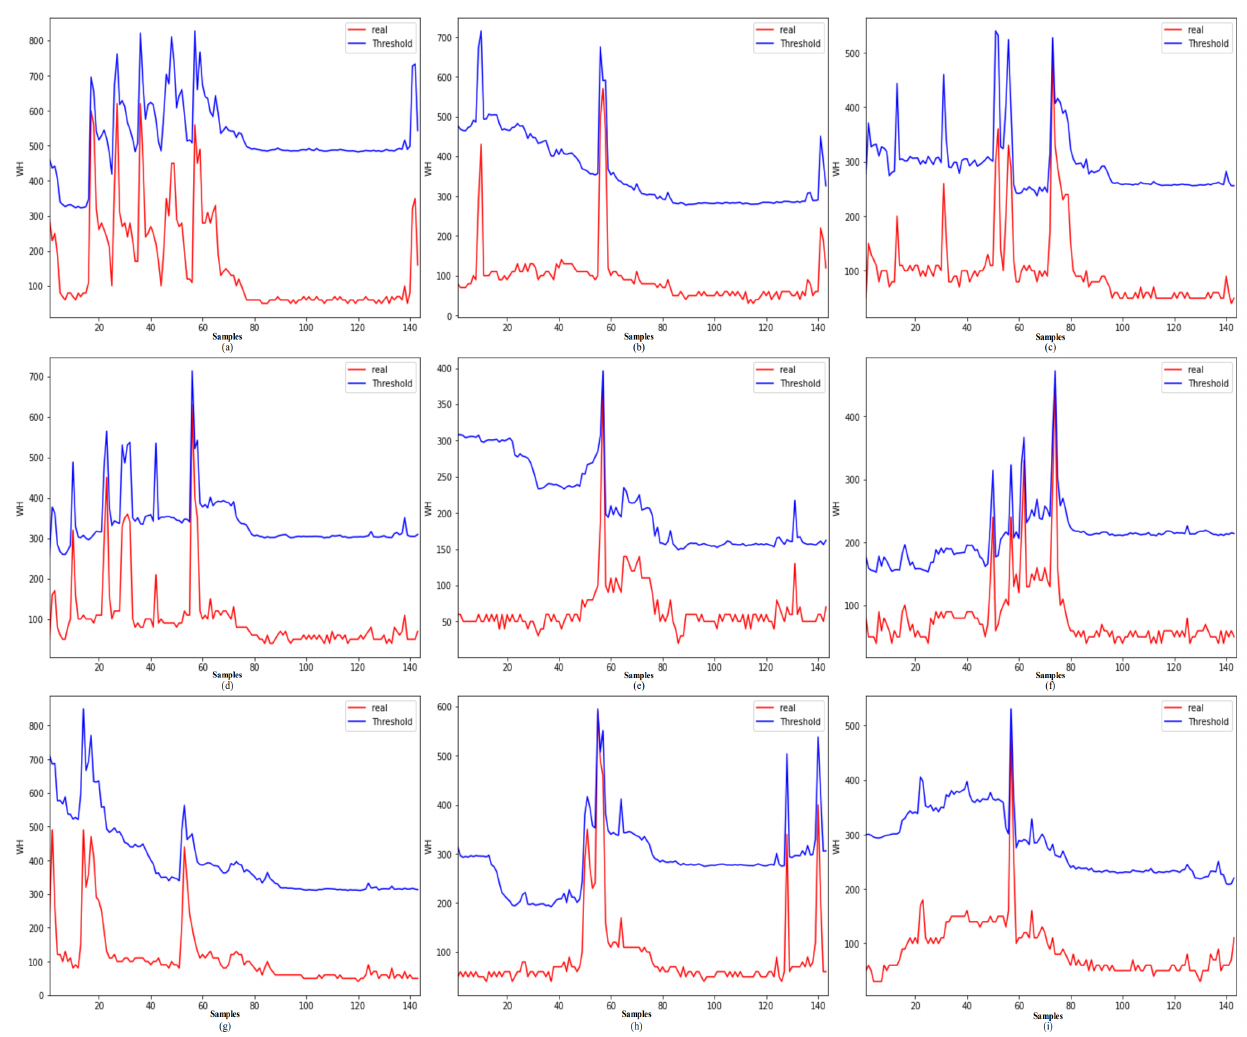
Figure 4. Example of the second group of normal energy consumption behavior: ( a ) electricity consumption on 13 May; ( b ) electricity consumption on 14 May; ( c ) electricity consumption on 15 May; ( d ) electricity consumption on 16 May; ( e ) electricity consumption on 17 May; ( f ) electricity consumption on 18 May; ( g ) electricity consumption on 22 May; ( h ) electricity consumption on 23 May; ( i ) electricity consumption on 24